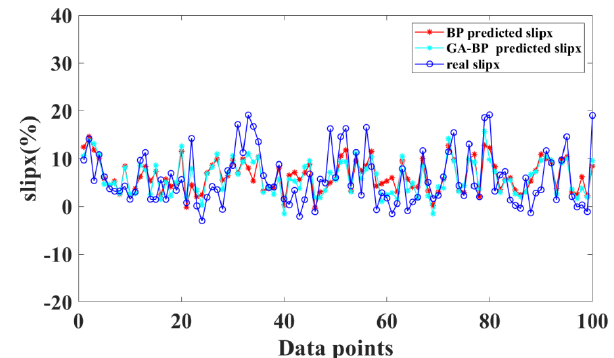
Figure 11. BP predicted slip_ x , GA-BP predicted slip_ x, and real slip_ x (part of the results).